Question: Write a descriptive caption for this figure.
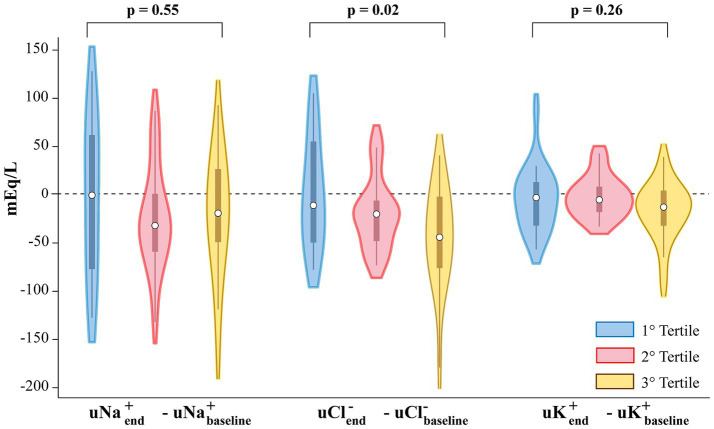
Answer: Difference between the end of the study and baseline urinary electrolytes, stratified by tertiles of the mean SID INF –HCO₃ − difference. Blue plots represent the first tertile, red plots the second tertile, and yellow plots the third tertile. Variations are calculated as the difference between end-of-study and baseline values for each parameter. Data are presented as violin plot (median reported by the white dot, 25th-75th percentile, whiskers indicate the 10th–90th percentiles). p values refer to one-way analysis of variance (ANOVA) performed for each electrolyte.